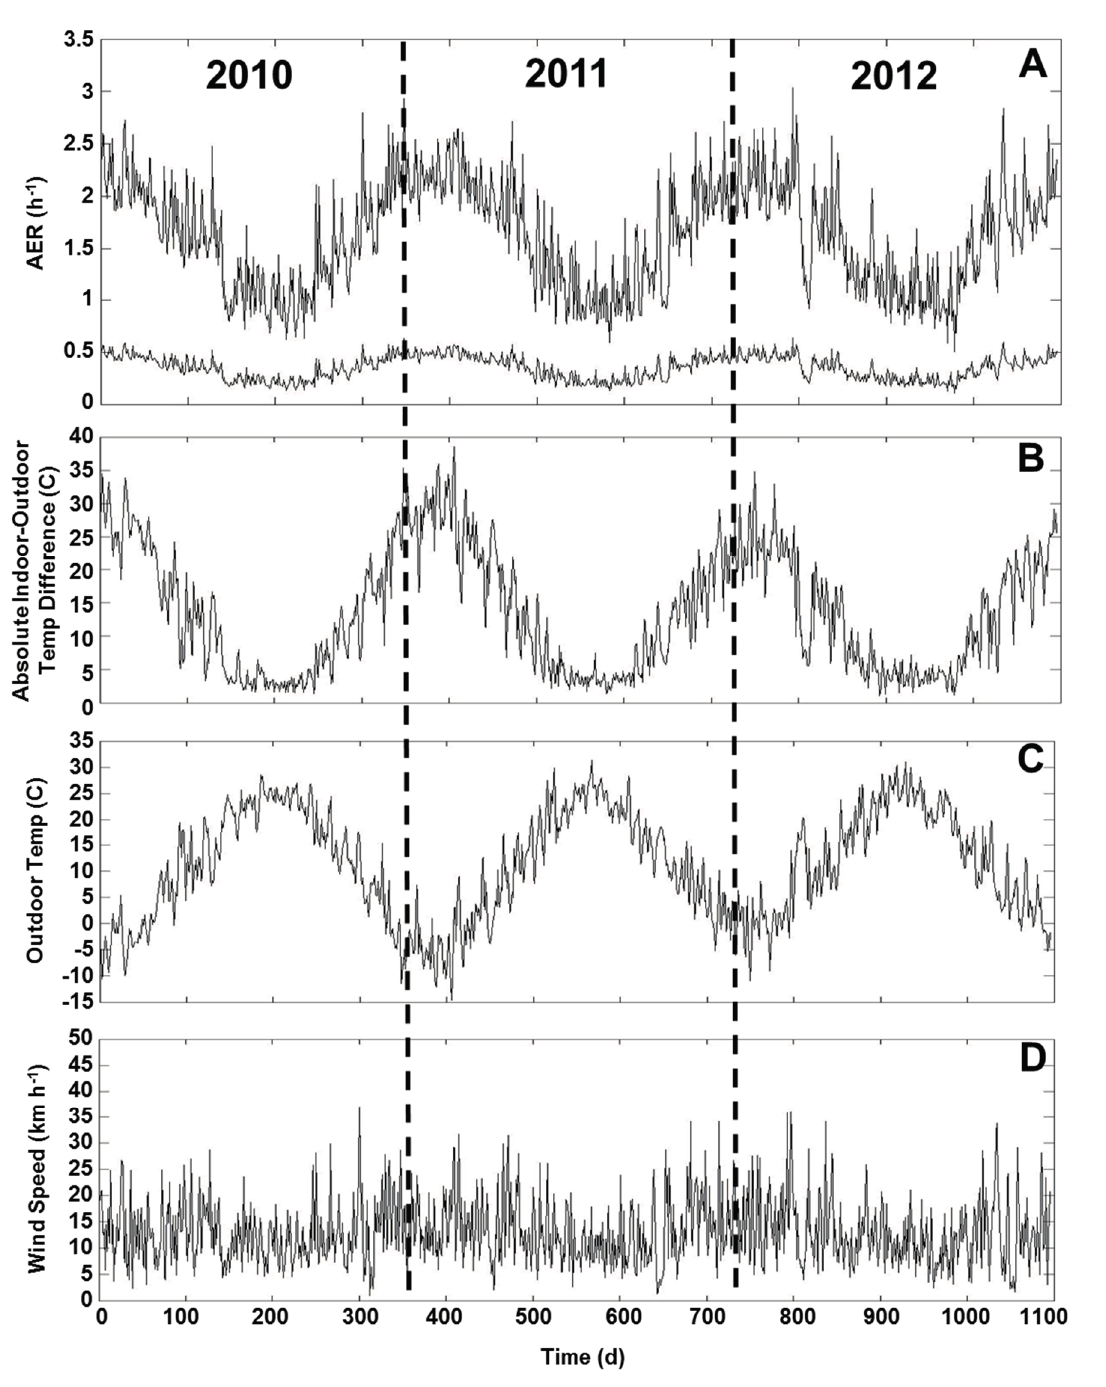
Figure 4. Time-course of AER predictions ( A ), absolute indoor-outdoor temperature differences ( B ), outdoor temperatures ( C ), and wind speeds ( D ) across the three years of health study. Two AER time-course plots correspond to homes with highest and lowest median AER predictions. Plots show daily 24 h average values across three years of health study from 1 January 2010 to 31 December 2012. AER oscillations correspond to indoor-outdoor temperature differences. AER transients of positive or negative spikes correspond primarily to wind speeds and secondarily to indoor-outdoor temperature